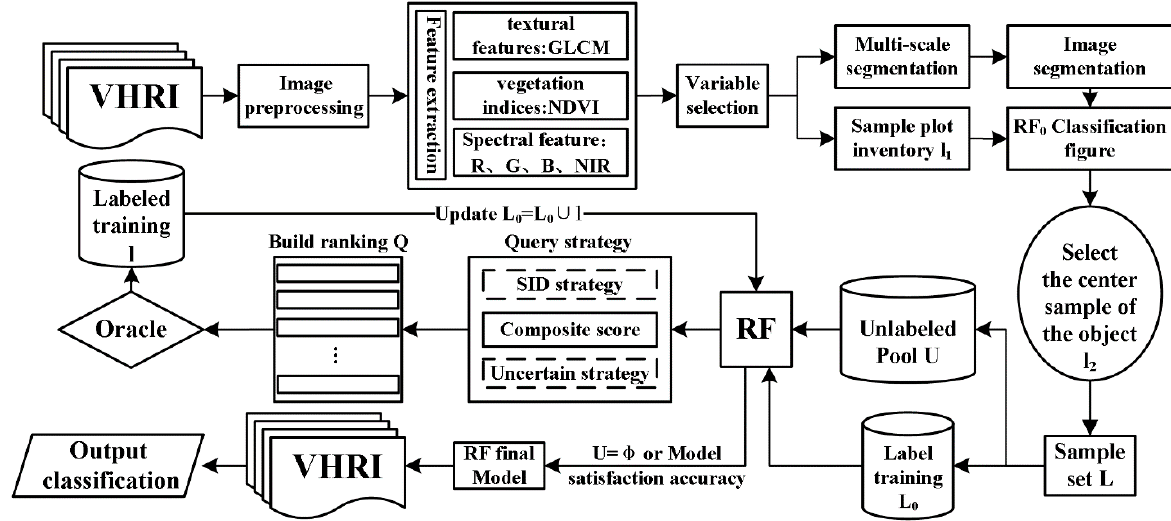
Figure 3. Overall workflow of the proposed AL algorithm.